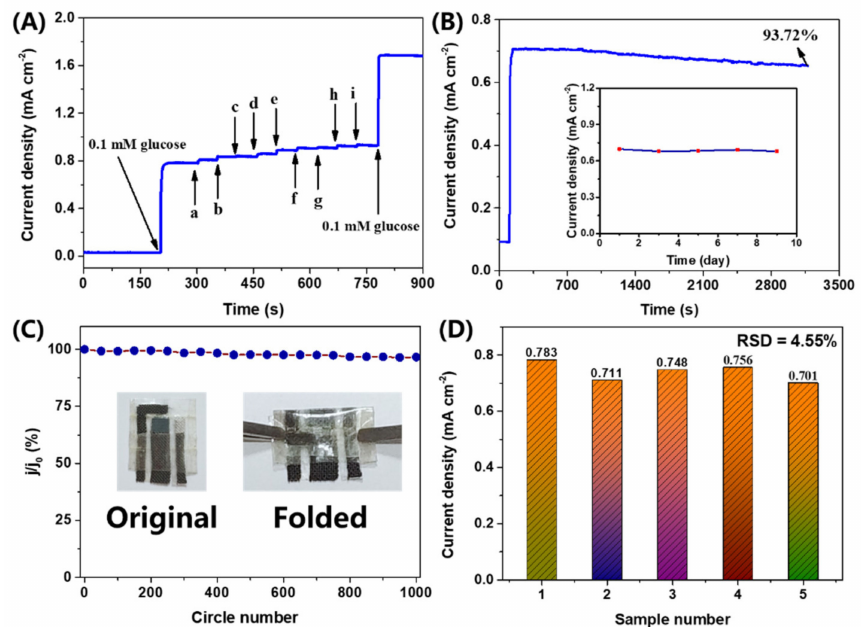
Figure 6. ( A ) Chronoamperometric response of Au@Cu(OH) 2 / CFC sensor toward the addition of 0.1 mM glucose and various interfering species. (a–i are Maltose, Fructose, UA, AA, DA, Cys, 4-AP, KCl and Na 2 SO 4 , respectively). ( B ) Long-term stability tests of the Au@Cu(OH) 2 / CFC sensor in 0.1 M KOH and 0.01 M KCl solution containing 0.1 mM glucose for over 3000 s and 9 days (inset). ( C ) Folded stability test of the Au@Cu(OH) 2 / CFC sensor; inset shows the repeating folded and recovery process (j is current response density of the original sensor and j 0 is current response density of the folded sensor). ( D ) The